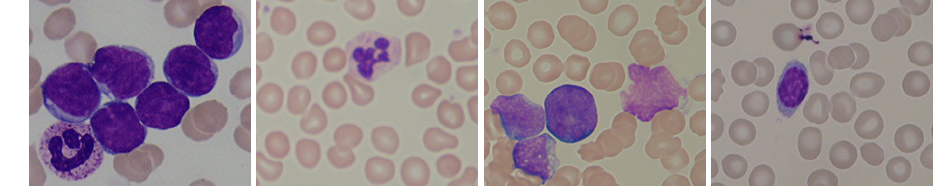
Figure 3. Blood images containing leukocytes, extracted from ALL-IDB1. First of all, they present different coloration and illumination conditions; therefore, their analysis should consider the consequent color variability. Moreover, further issues are represented. From left to right: leukocytes’ clump formation, light blur, and low contrast between the background and the cytoplasm of WBCs, the presence of deformed WBCs and staining artifacts (light violet regions, similar to WBC’s shape), poor contrast, and the presence of an artifact.